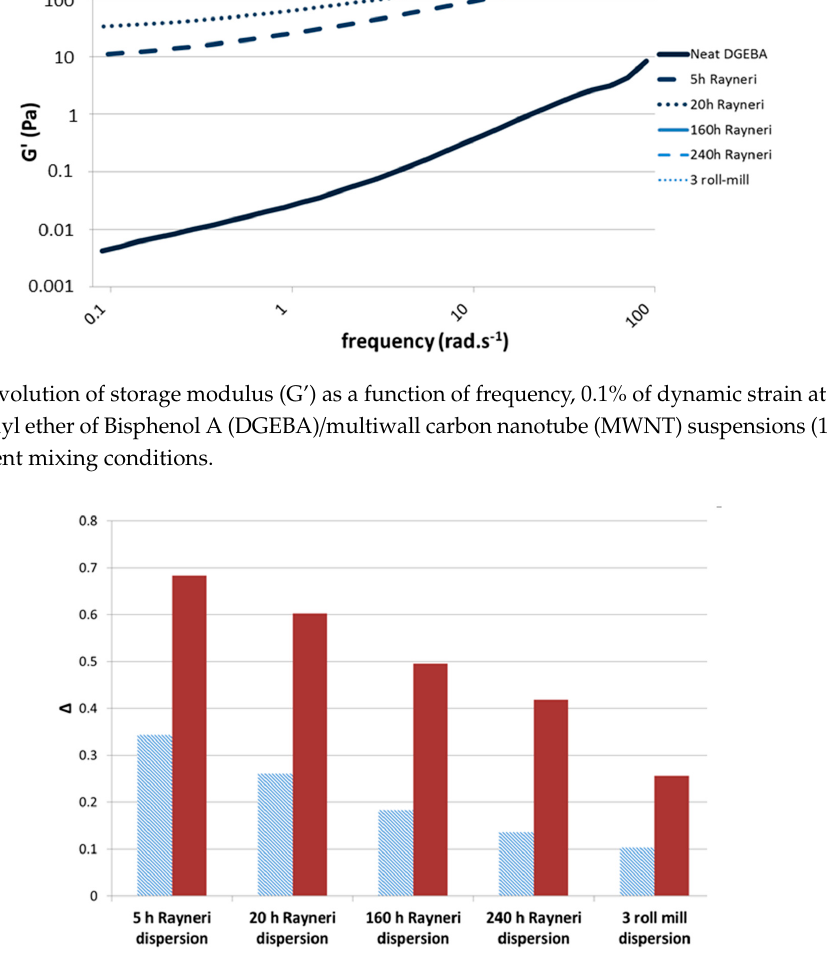
Figure 3. ∆ exponent from the power law of G’ (hatched light) and G’’ (full dark) with the frequency (from 0.1 to 1 rad/s) at 25 °C for DGEBA/MWNT suspensions (1 wt %) with different mixing conditions.